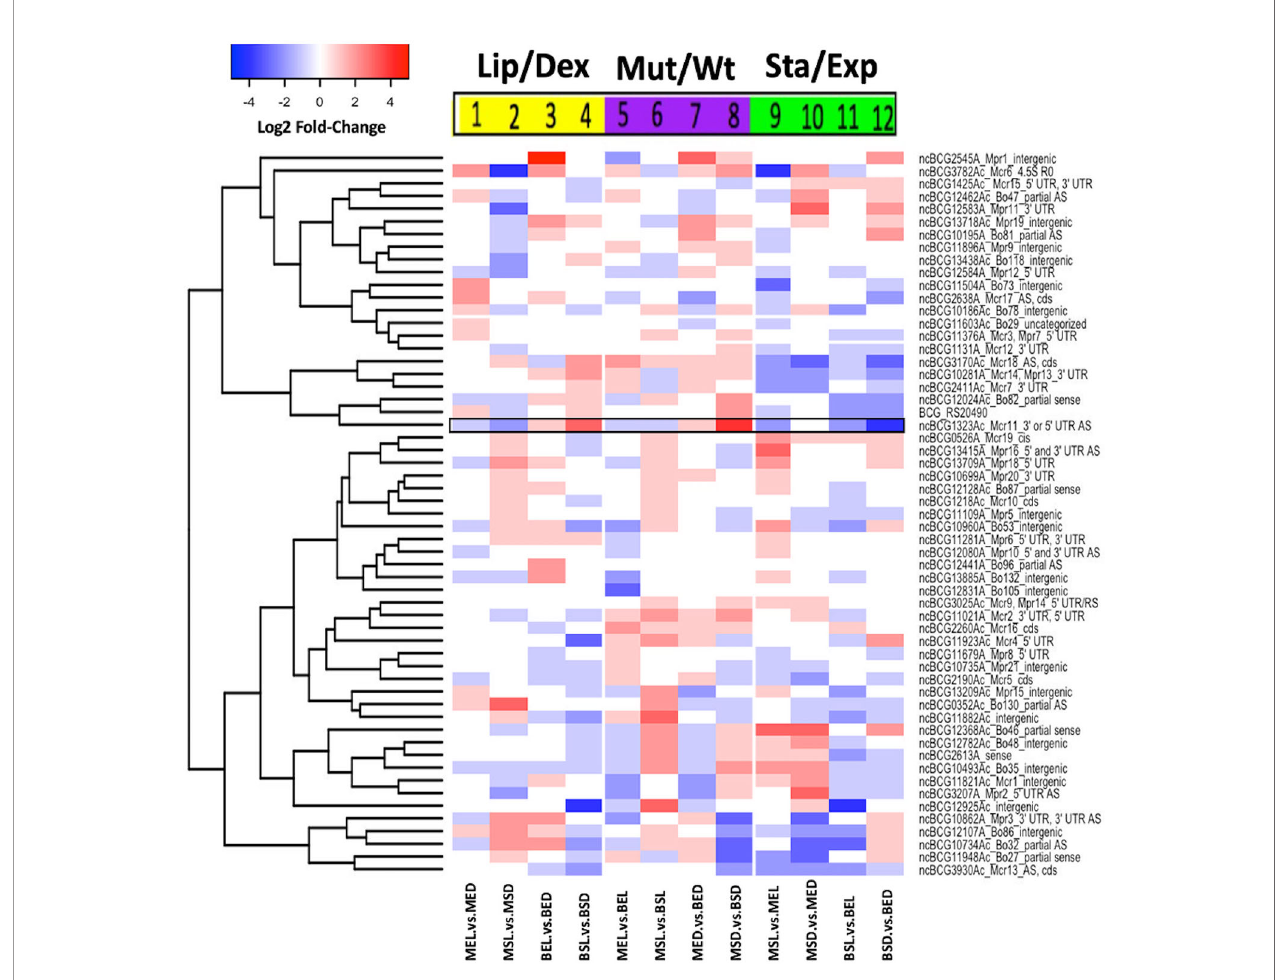
FIGURE 4 | Comparative expression of non-coding RNAs from M. bovis BCG. Log2 fold-change values of ncRNAs are shown. All experiments were performed as previously described in the methodology section. wtBCG or mtBCG strains cultured in dextrose or lipids during exponential (BED, wtBCG dextrose; BEL, wtBCG lipids; MED, mtBCG dextrose; MEL, mtBCG lipids) or stationary phases (BSD, wtBCG dextrose; BSL, wtBCG lipids; MSD, mtBCG dextrose; MSL, mtBCG